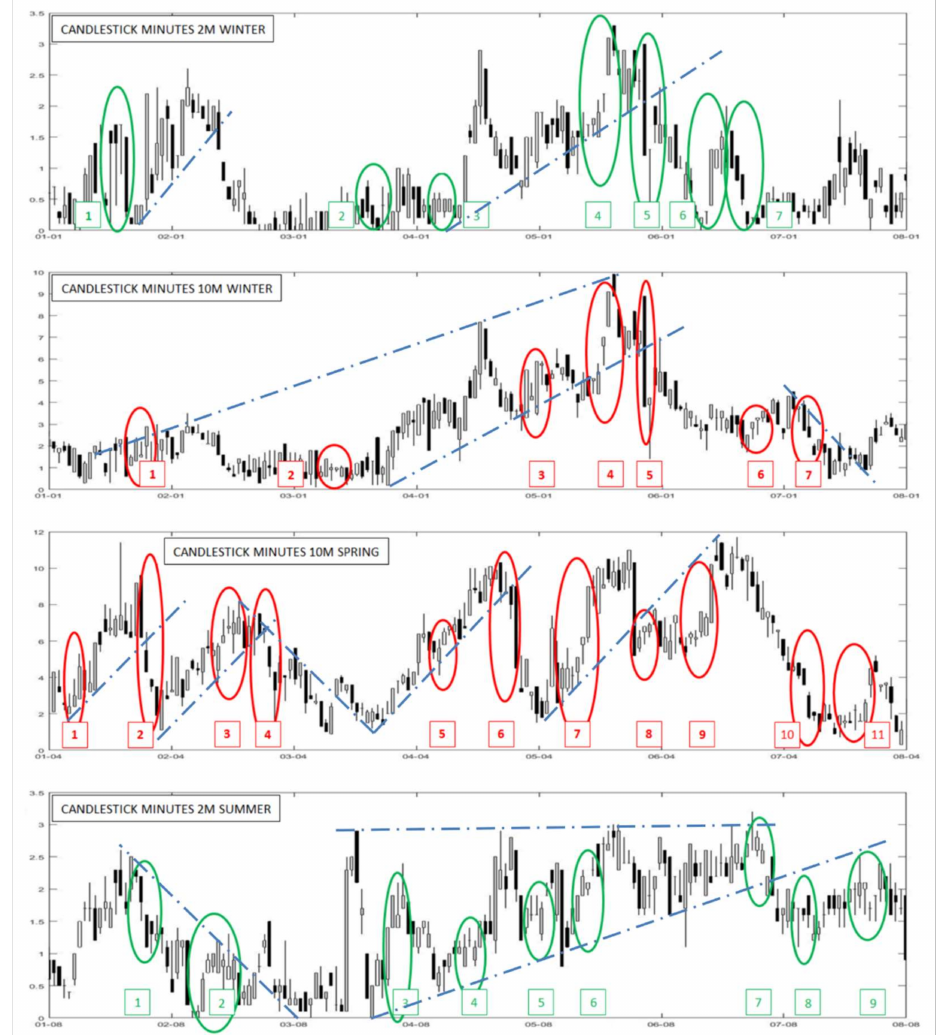
Figure 8. Some examples of identification of trend lines on candlestick charts for Los Montes del Cierzo, hourly